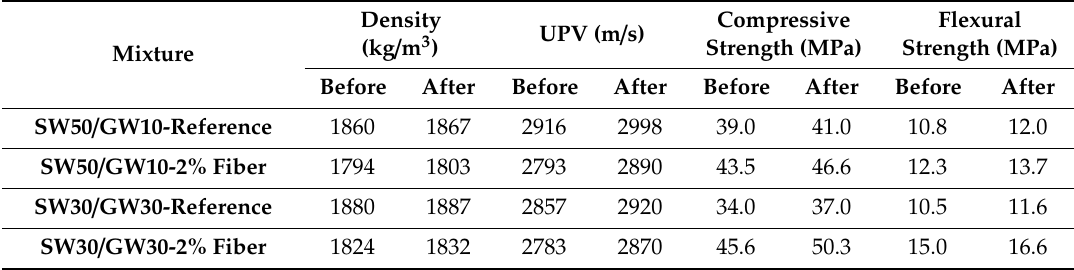
Table A1. E ff ects of carbonation on the hardened state properties of the reference and fiber reinforced mixtures (no foam).